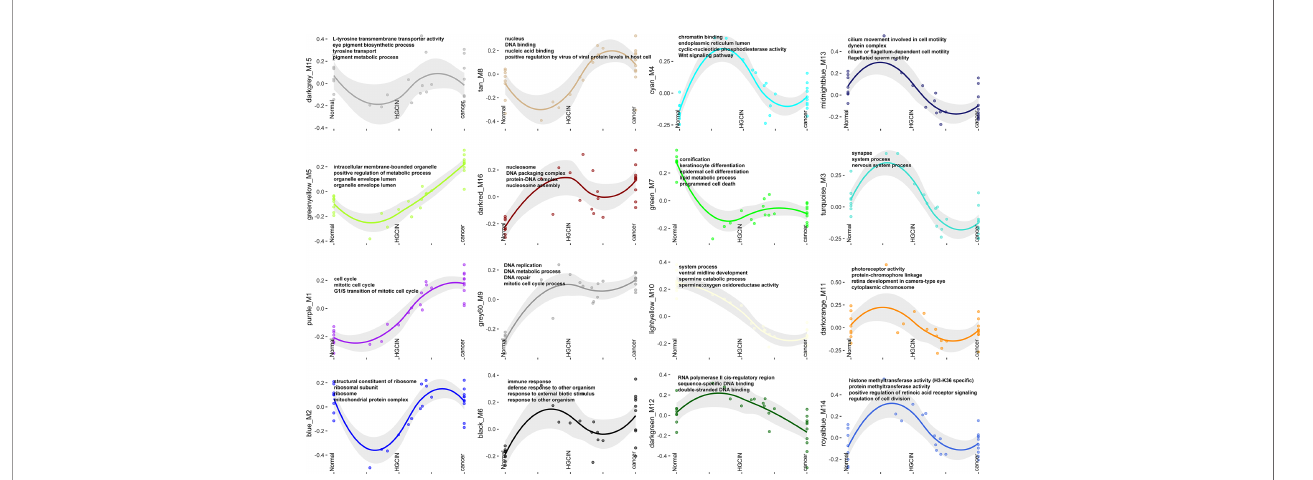
FIGURE 2 | GO functional enrichment analysis. GO terms associated with each of the 16